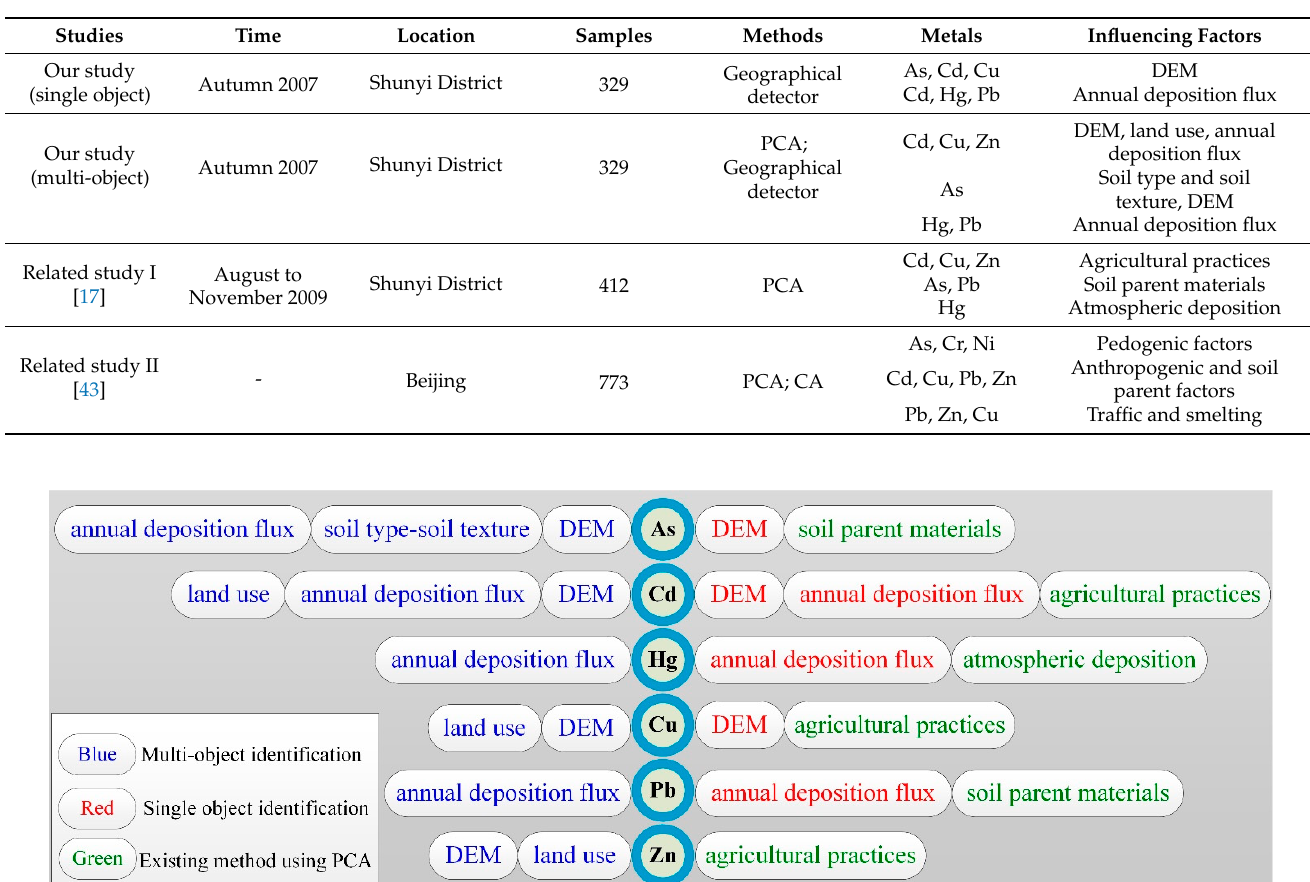
Table 7. The comparative results between this study and related studies.